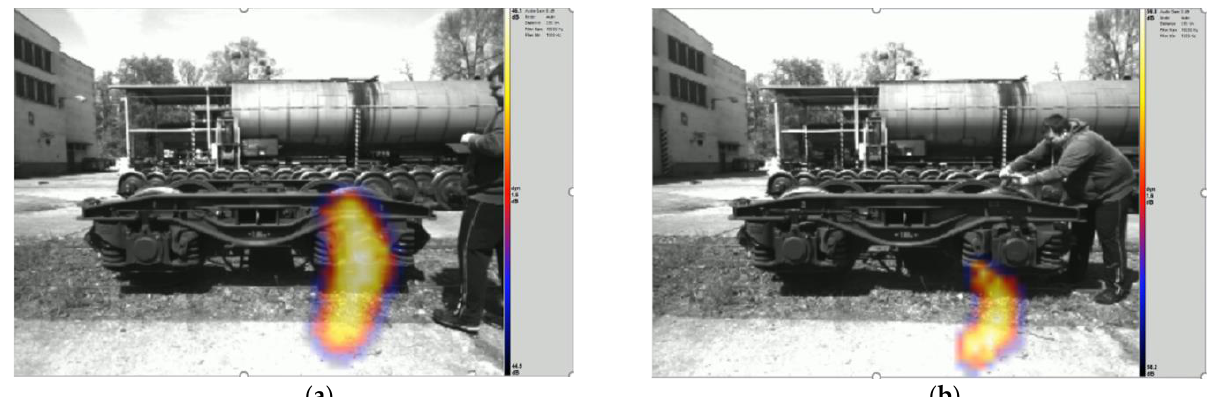
Figure 7. Recording of acoustic pressure LF MAX (dB) generated by wheel excitation by acoustic camera — ( a ) without insulation, and ( b ) with insulation (1 s after stroke).